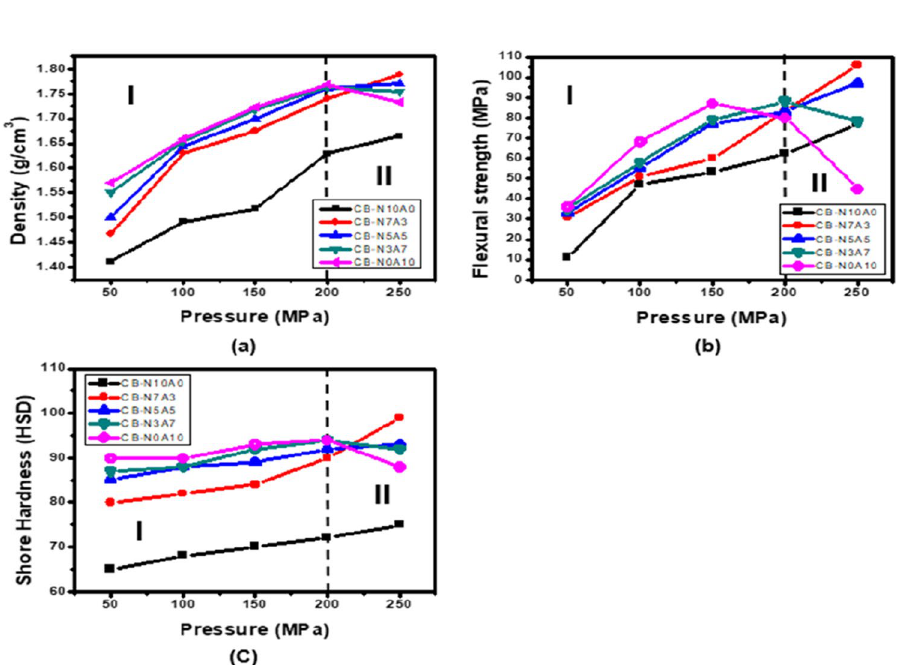
Figure 6. Changes in ( a ) density, ( b ) flexural strength, and ( c ) shore hardness due to the molding pressure of the high-density carbon block after